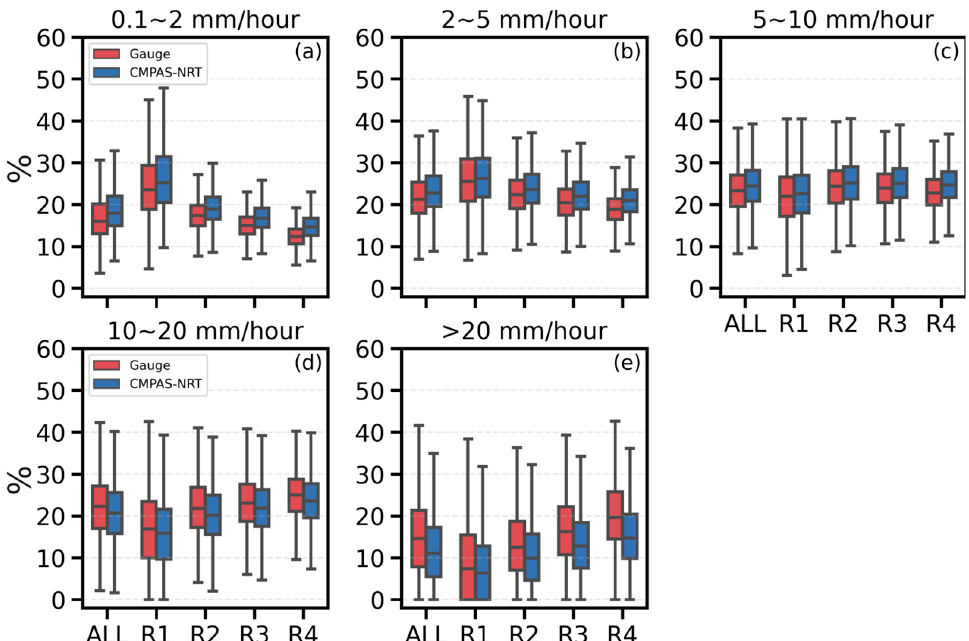
Figure 12. Relative contribution of precipitation occurring in different hourly precipitation threshold intervals to the total precipitation (including each subregion and the whole region) for the whole rainy period in 2020 from surface rain-gauge observations (red) and CMPAS-NRT products (blue). Panels ( a – e ) respectively represent the hourly precipitation thresholds of 0.1–2 mm/h, 2–5 mm/h, 5–10 mm/h, 10–20 mm/h, and >20 mm/h.